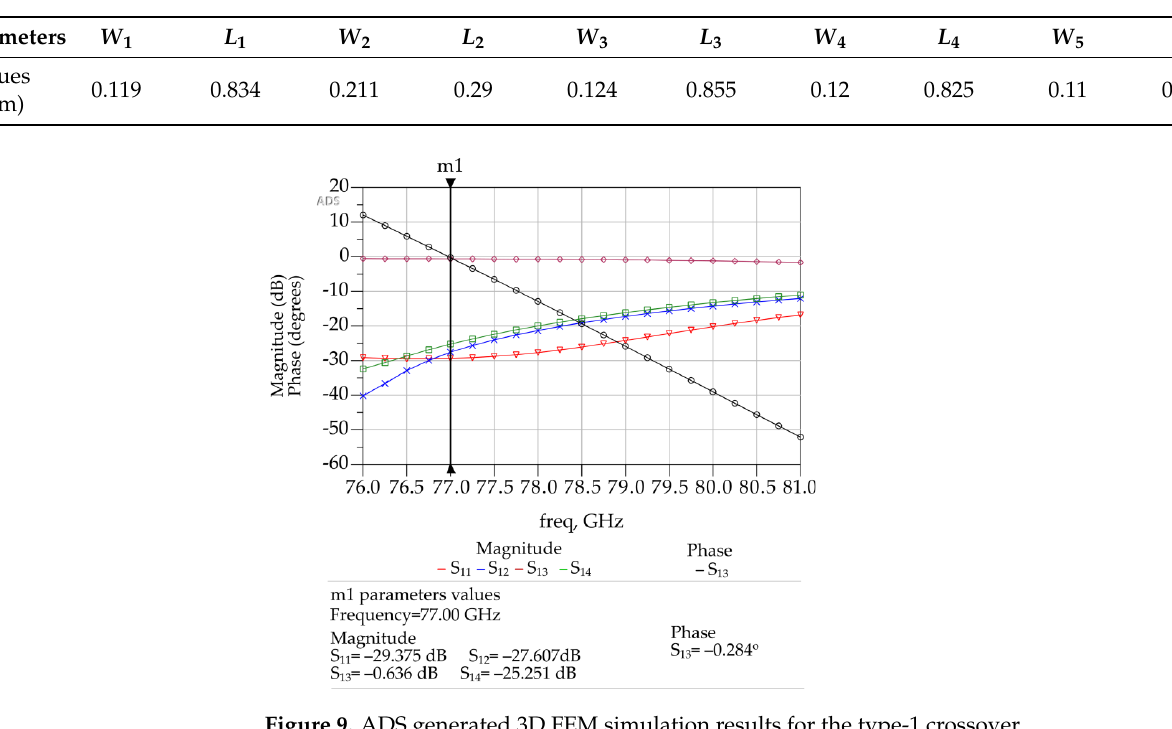
Figure 10. Layout of the type-2 crossover in ADS.